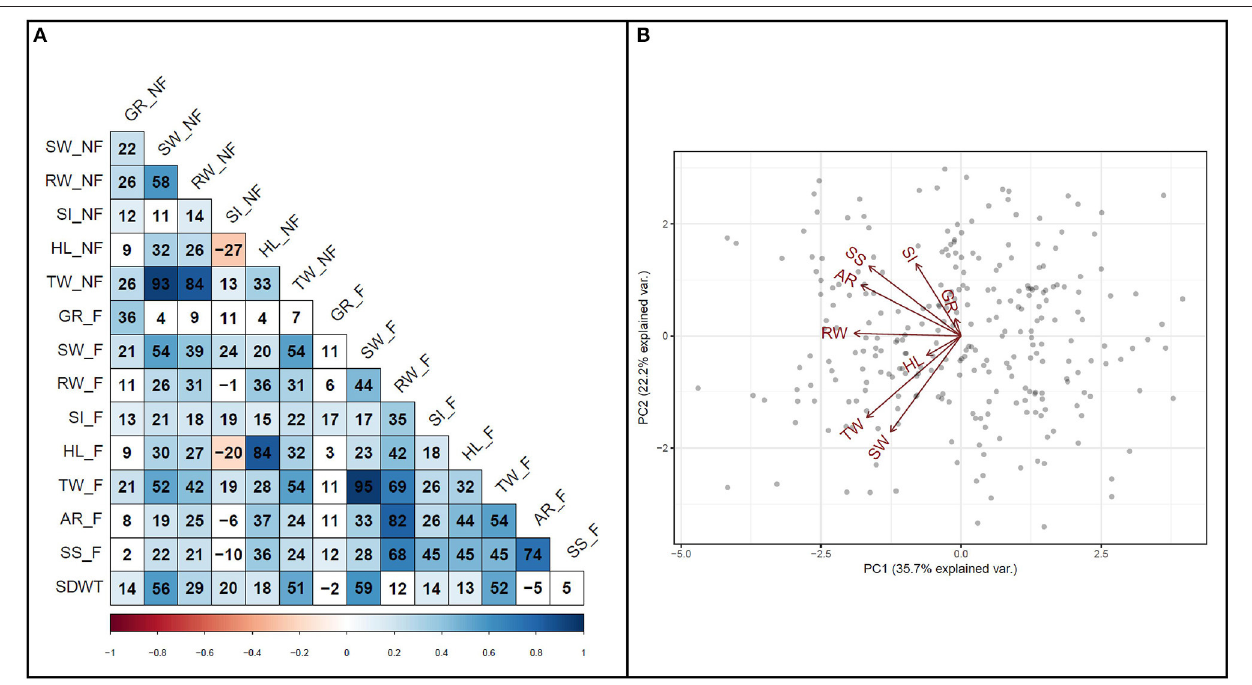
FIGURE 4 | Relationship among traits. (A) Pearson correlation coefficients among traits measured under flooded and non-flooded. Correlation coefficients multiplied by 100. (B) Biplot representing the relationship among different flooding indices used to separate genotypes. Traits evaluated in non-flooded and flooded conditions represented by _N and _F, respectively after the name of the trait. TW, total weight; SW, shoot weight; RW, root weight; HL, hypocotyl length; SI, SPAD index; GR, germination rate; AR, adventitious root formation; SS, survival score and SDWT, seed